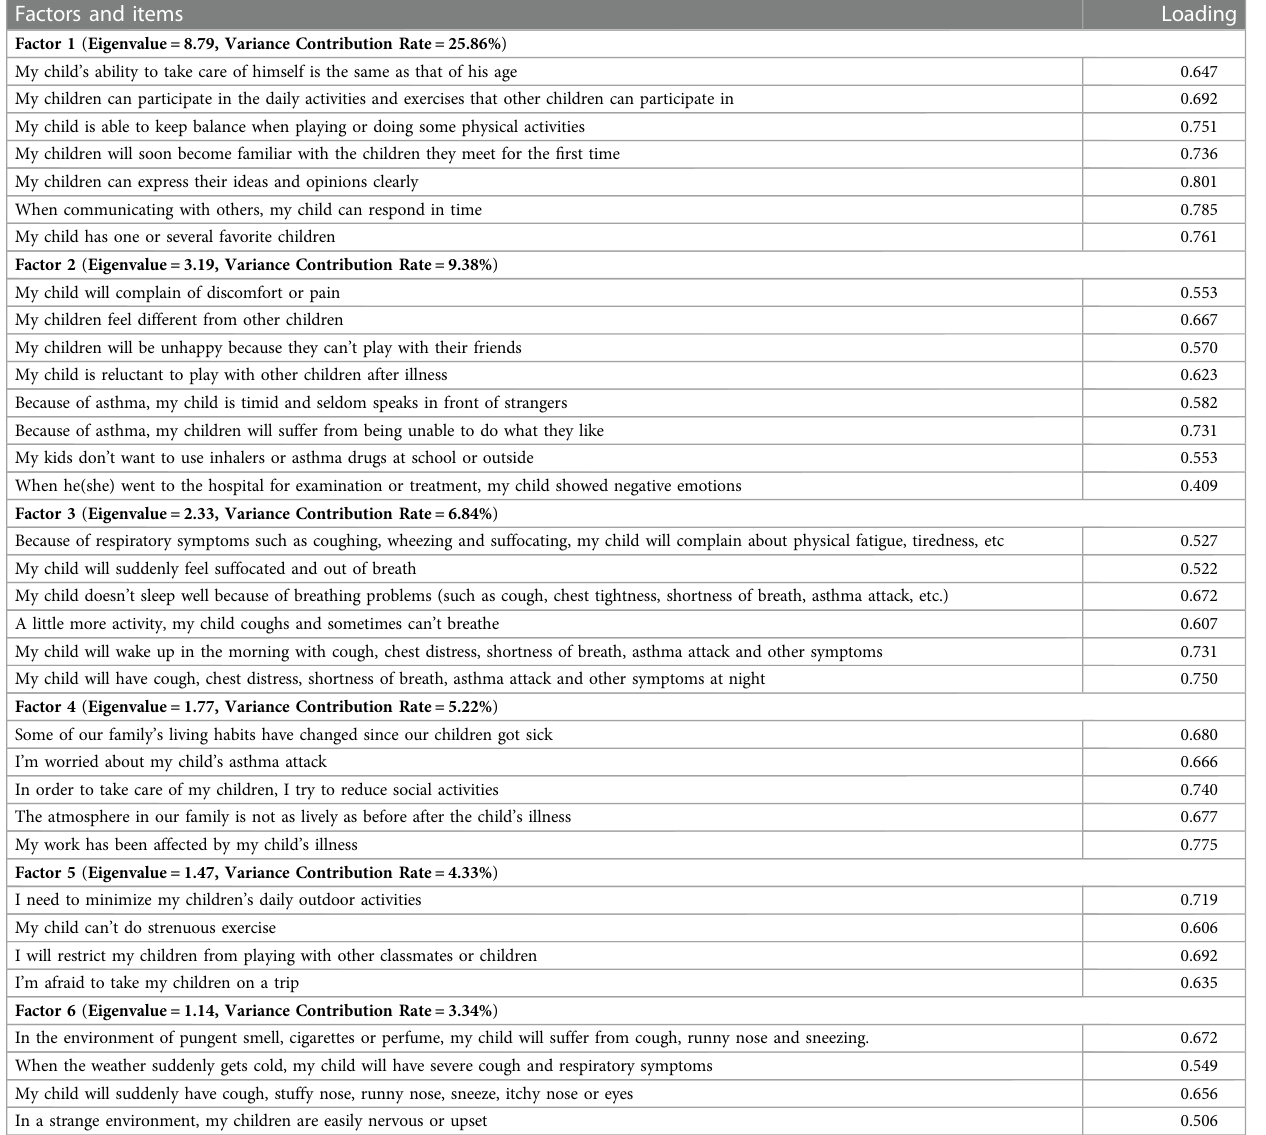
TABLE 2 Items and factor loading of the fi nal questionnaire reported by caregivers ( n =428). Factors and